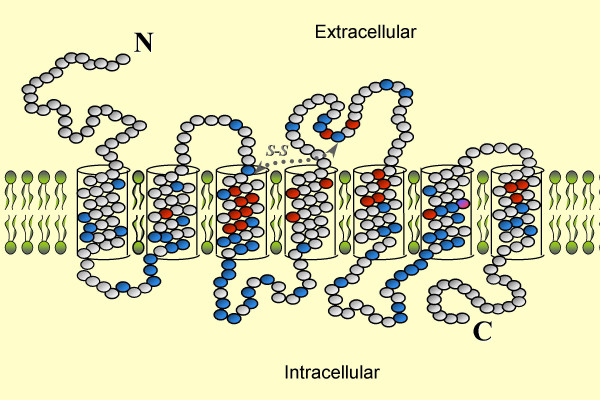
Localization of conservation core residues in the framework of a 2-dimensional OR diagram. The inferred locations 65 conservation core residues are shown in blue. For reference the 22 highly variable putative OR complementarity determining residues (CDRs) [19] are also show in red.